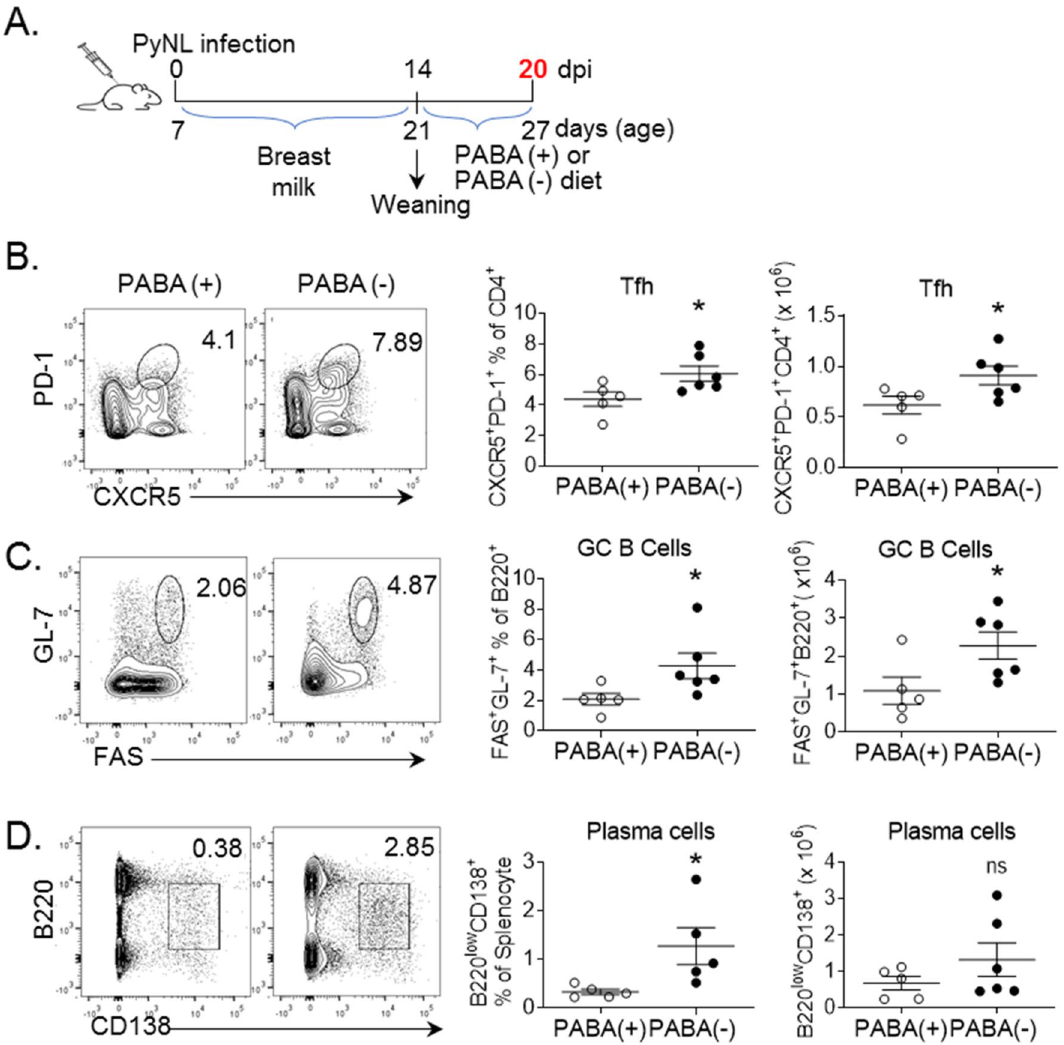
Figure 4. Mice fed with PABA negative diet develop Tfh cells, GC B cells and plasma cells despite experiencing low parasitemia. ( A ) Groups of 6- to 7-days old NB mice were infected (i.p.) with 1 × 10 6 PyNL parasites and splenic Tfh cells, GC B cells and plasma cells were analyzed at 20 dpi. NB mice remained on breast feeding until 21 days of age when they were switched to PABA-containing or PABA-deficient diet. Mice in both groups were sacrificed at 20 dpi and splenocytes were analyzed in flow cytometry. Representative dot plots depicting the percentage and cell numbers of splenic PD-1 + CXCR5 + (Tfh) cell on CD4 + pre-gated T cells ( B ), GL-7 + FAS + (GC B cells) on B220 pre-gated B cells ( C ) and B220 low CD138 + on pre-gated live cells ( D ) and the accompanying mean percentages and cell numbers were plotted. One out of two experiments with similar results is shown. Results are expressed as mean ± SEM (n = 5); *p < 0.05 indicates PABA + vs PABA- diet fed